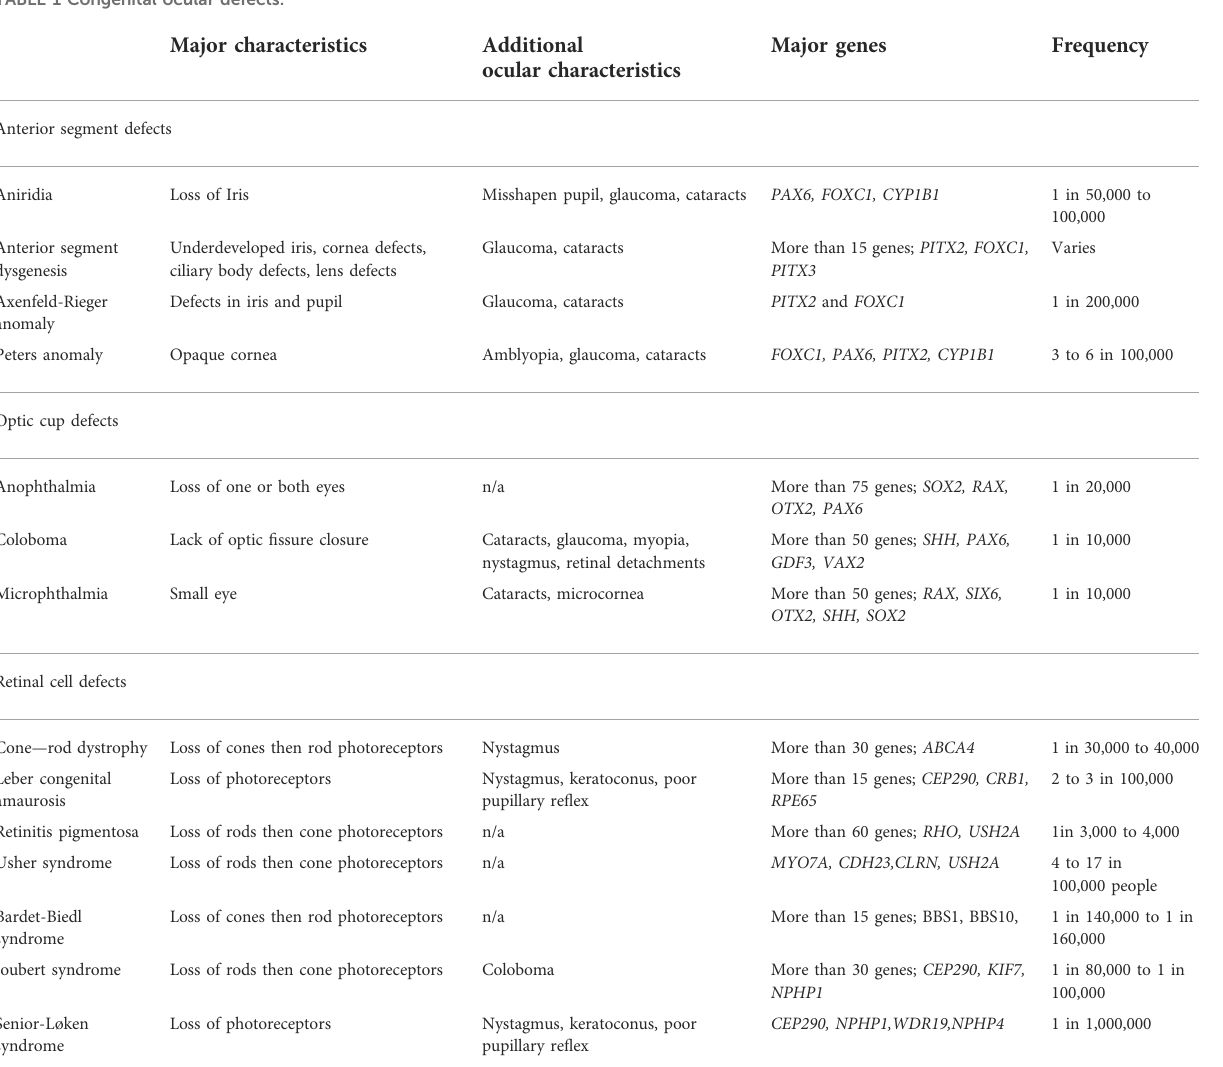
TABLE 1 Congenital ocular